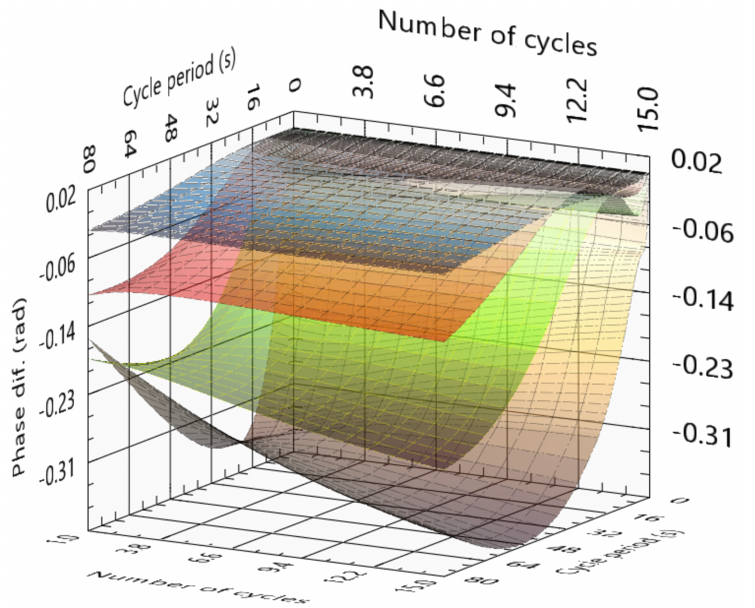
Figure 13. Phase difference function of cycle period, number of cycles, and for slots 1 to